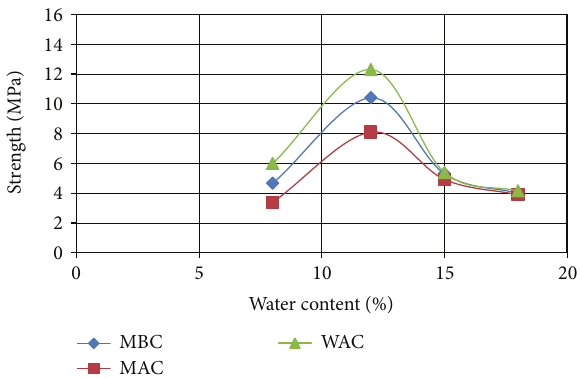
Figure 18: UCS for different water contents (4% cement) (soaked durability condition).